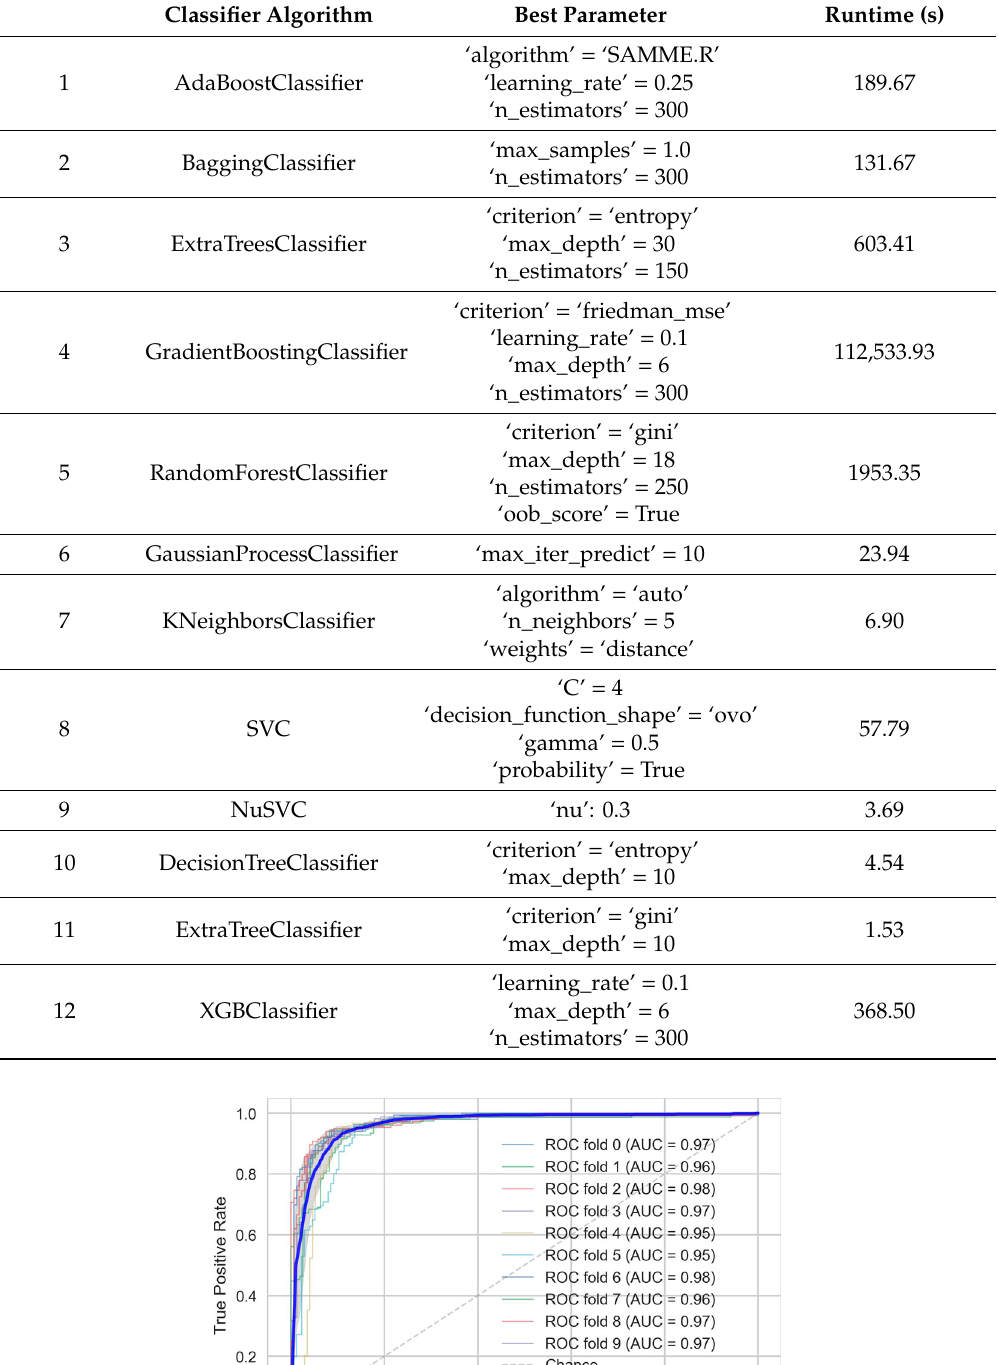
Table 4. Model optimal super parameter results and the time consumed. (Note: Please refer to the Scikit-learn website for the explanation of each parameter and its role in model adjustment: https: // scikit-learn.org).